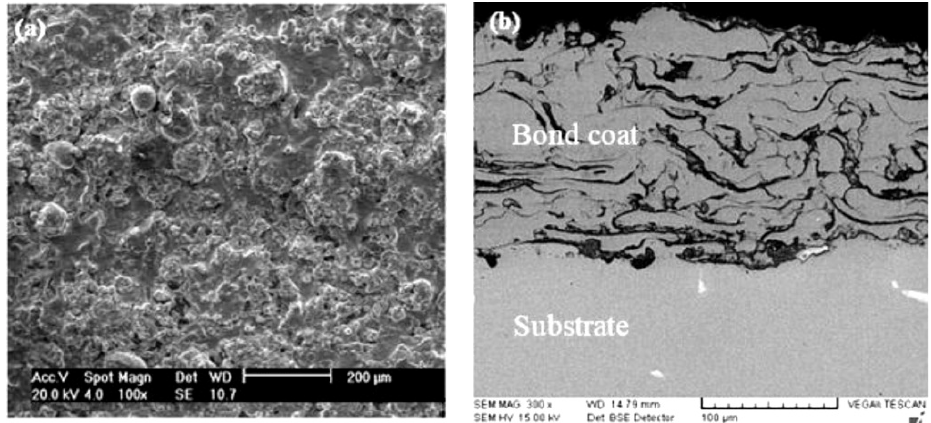
Figure 12. The micromorphology of pre-oxidized BC [120]. ( a ) The surface morphology of the as-sprayed BC; ( b ) the micro cross-section of the as-sprayed BC.